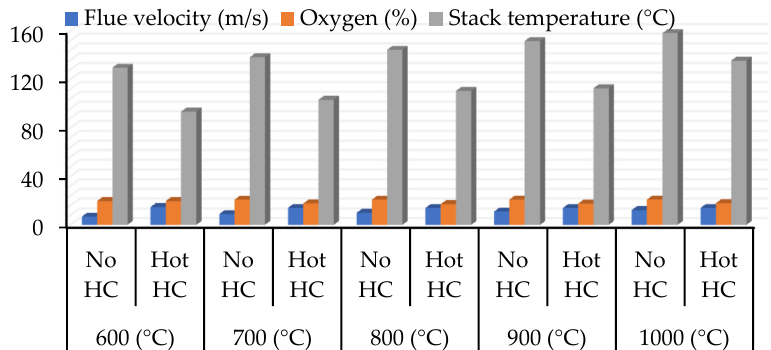
Figure 4. Comparative stack temperature, flue, and percentage oxygen from heat-treated catalyzed and non-heat-treated catalyzed rice husk combustion. Note: Hot HC is heat-treated catalyst; No HC is